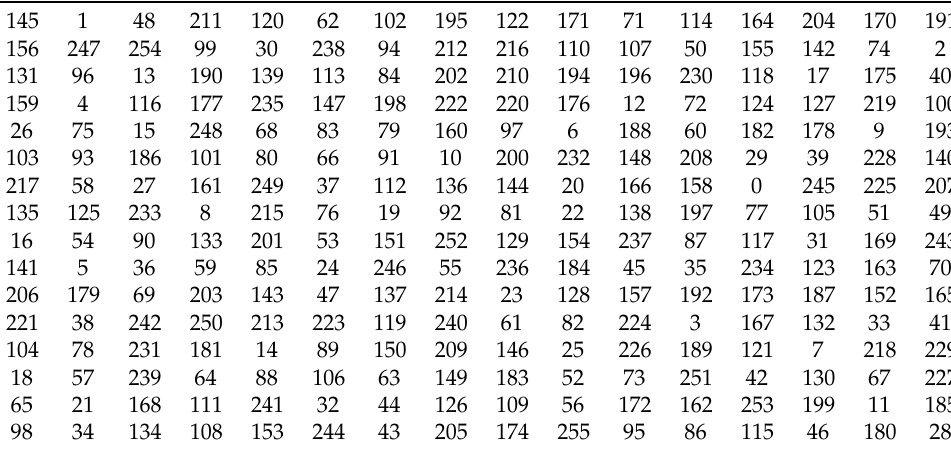
Table 1. Nasir’s S-Box2